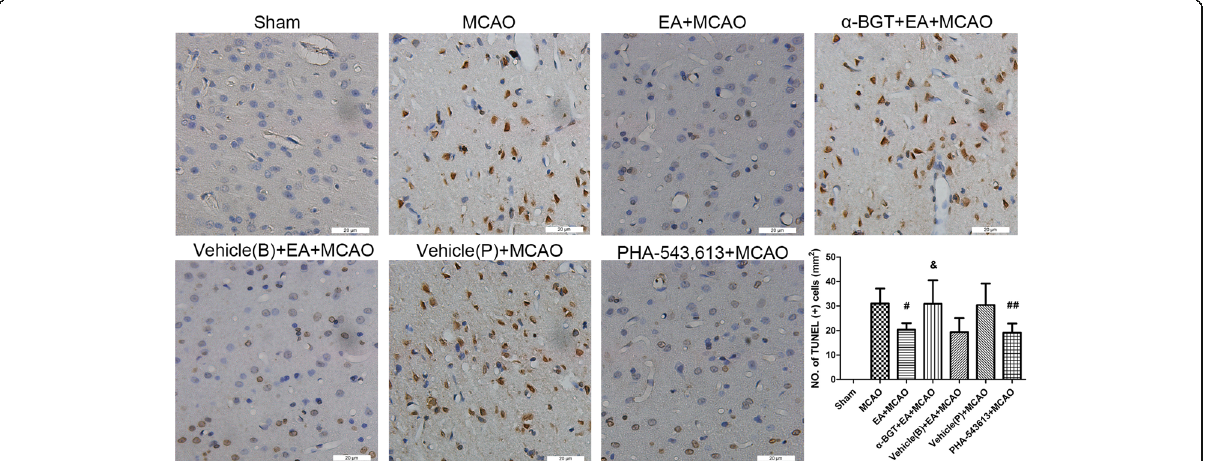
Fig. 7 Cellular apoptosis at 3days after reperfusion ( n =8). Representative TUNEL staining and the number of TUNEL positive cells. Compared with MCAO group, the cellular apoptosis was reduced in EA+MCAO group. When compared with EA+MCAO group, the cellular apoptosis was increased in α -BGT+ EA+MCAO group. Intraperitoneal injection of PHA-543,613 reduced TUNEL positive cells when compared with MCAO groups. # P <0.05, ## P <0.01 vs. MCAO group, & P <0.05 vs. EA+MCAO group; Bar=20 μ